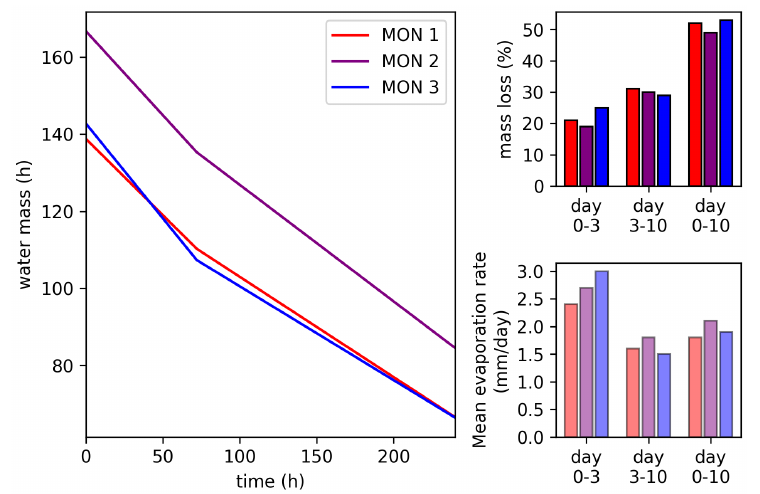
Figure 2. Mass changes vs. time ( left ), cumulative mass losses ( top right ) and evaporation rates ( bottom right ) during the